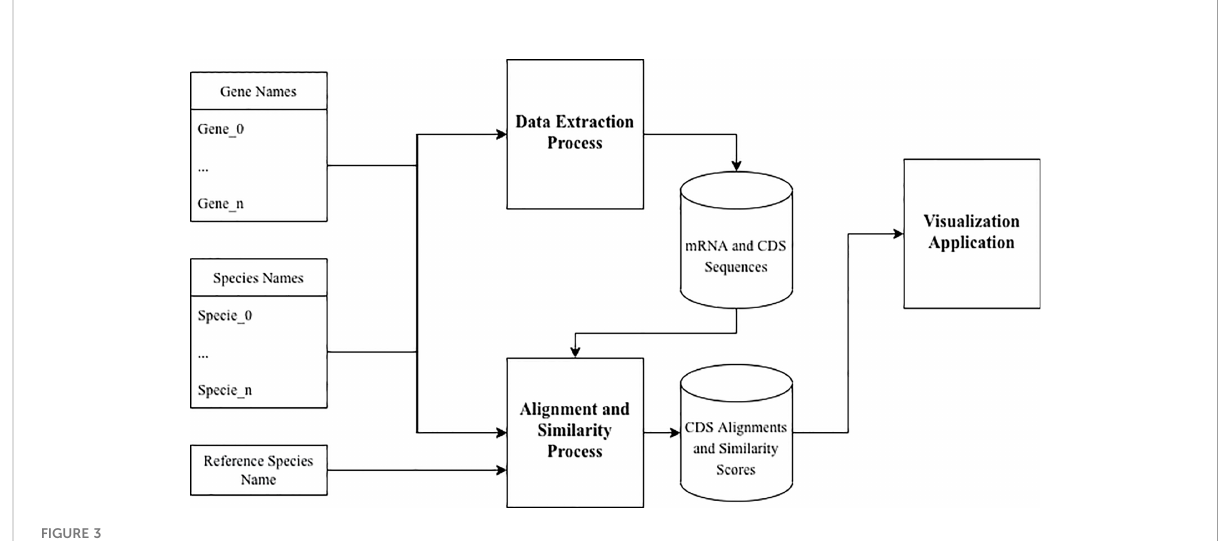
FIGURE 3 Process work fl